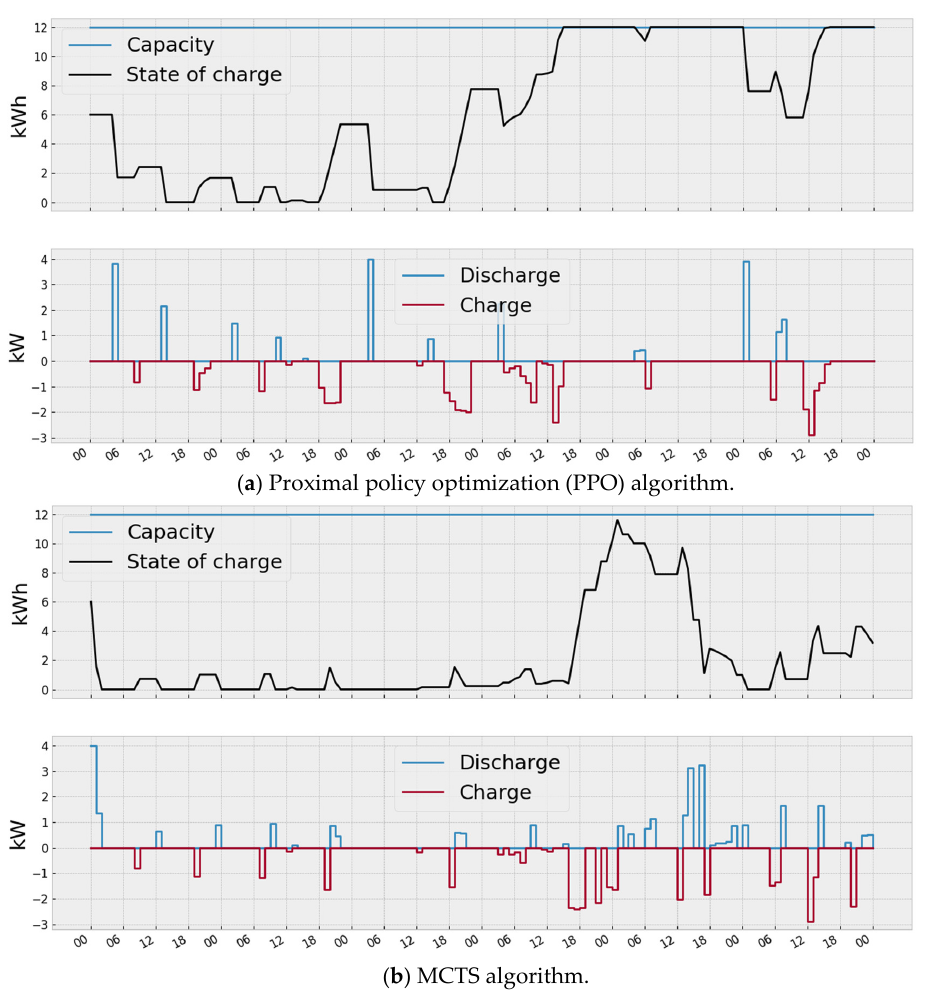
Figure 6. Dynamics of the charge and discharge of batteries for Case 1 for optimal policies, π ∗ obtained using PPO and MCTS algorithms for the one-week testing period.